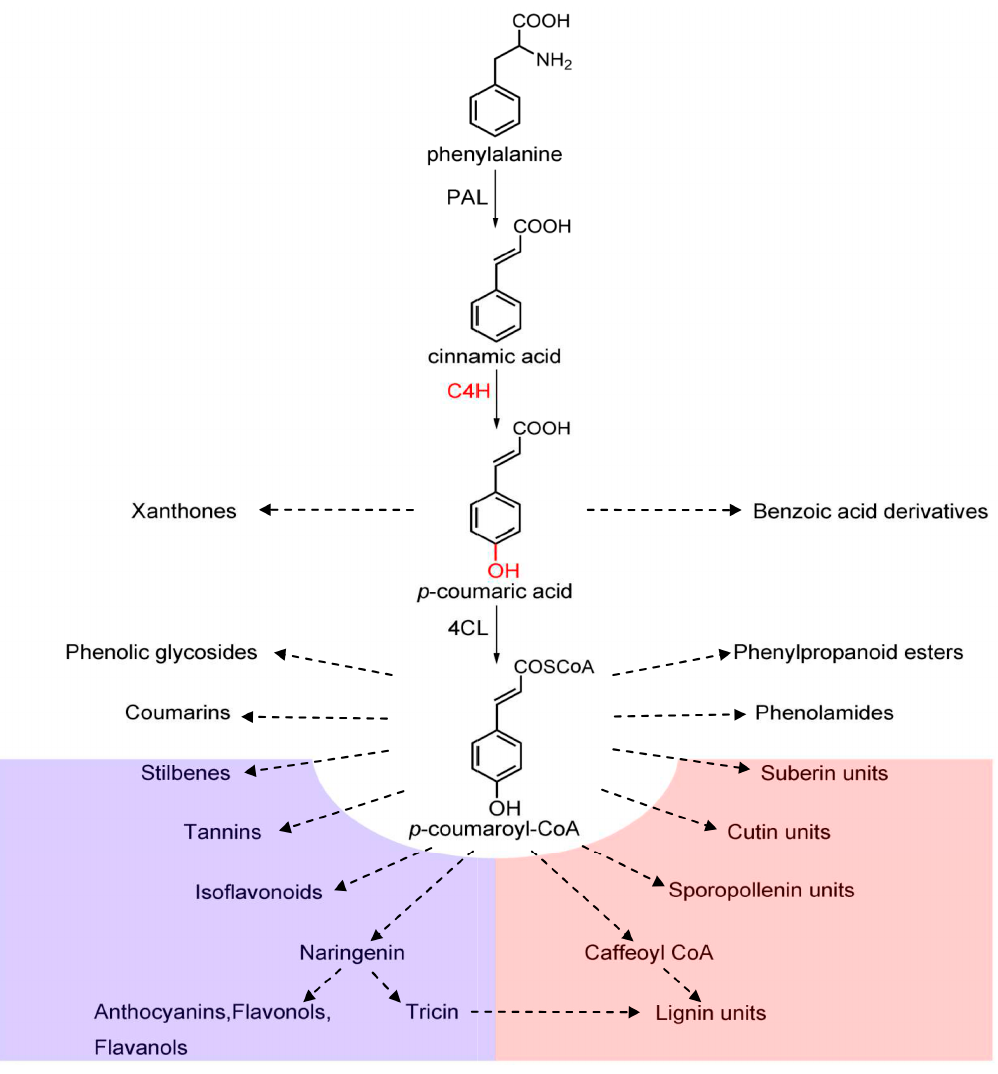
Figure 1. Schematic view of some branches of the phenylpropanoid pathway. PAL: phenylalanine ammonia-lyase; C4H: cinnamate 4-hydroxylase; 4CL: 4-coumarate: coenzyme A